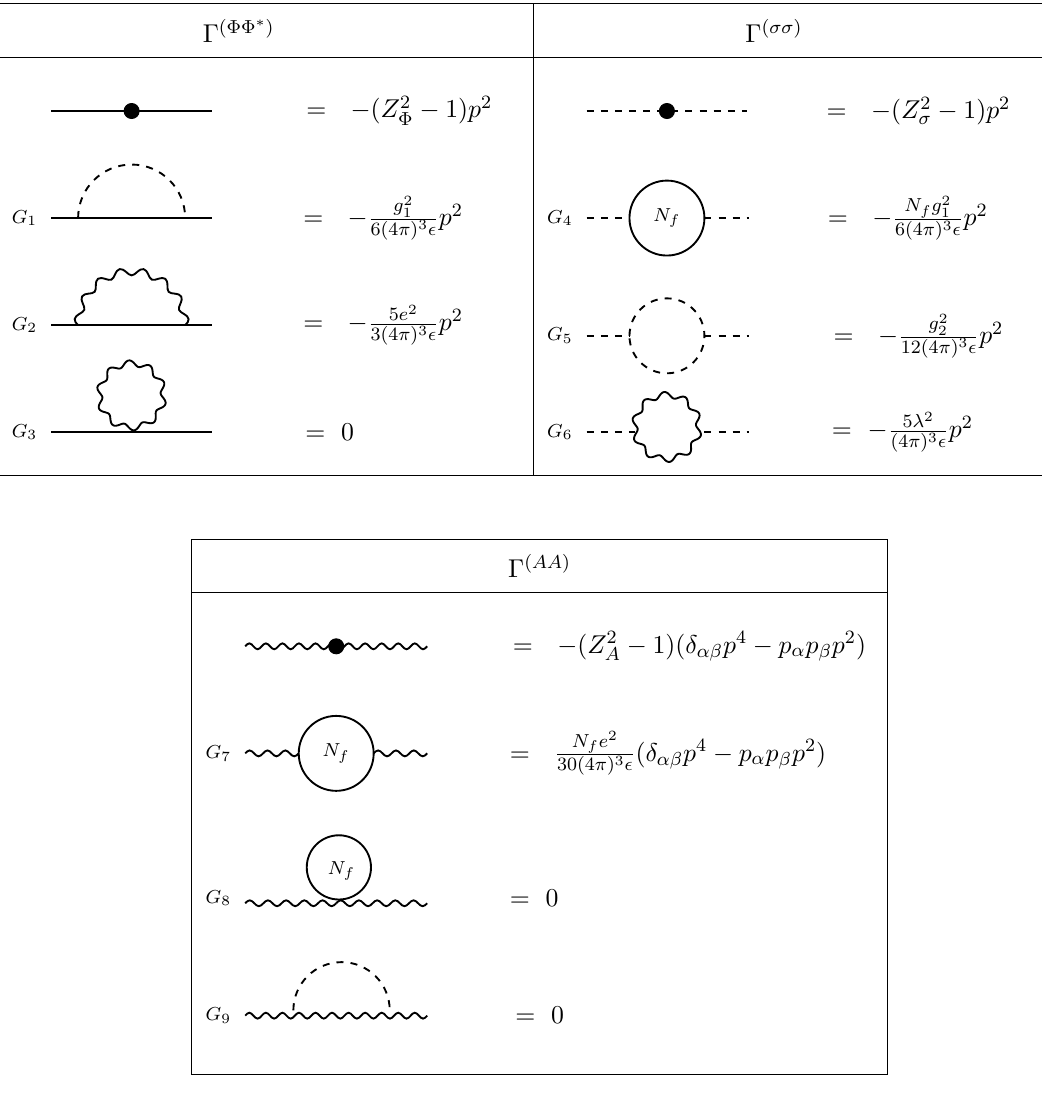
Table 2 . 2-point Green functions in the one-loop